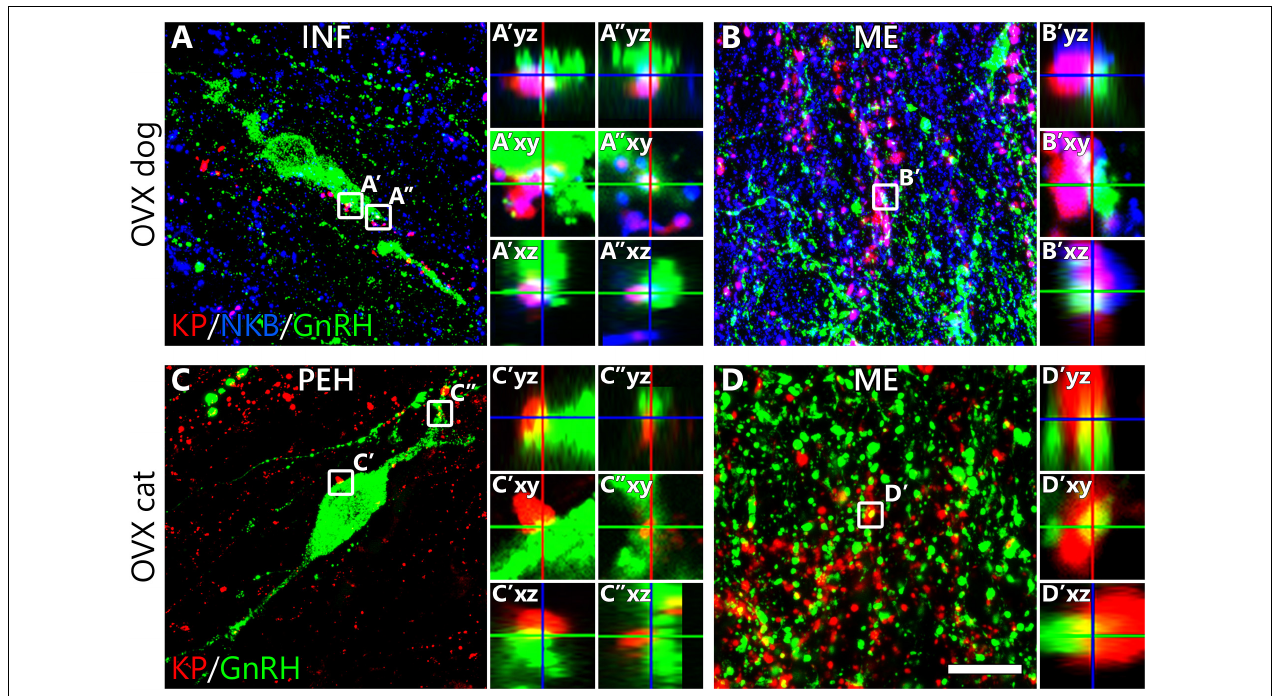
FIGURE 3 | Kisspeptin innervation of canine and feline gonadotropin-releasing hormone neurons. Results of triple- and dual-immunofluorescent studies on ovariectomized dogs (A,B) and cats (C,D) , respectively, reveal that kisspeptin (KP) fibers (red) establish axo-somatic (A’,C’) , axo-dendritic (A”,C”) and axo-axonal (B’,D’) contacts with gonadotropin-releasing hormone (GnRH)-immunoreactive (green) neurons. Successful detection of neurokinin B (NKB) in fibers of the canine hypothalamus allows the identification of KP fibers that arise from KP/NKB dual-phenotype neurons of the infundibular nucleus. High-power images of framed regions show absence of gaps between the juxtaposed profiles in orthogonal side-views of contacts. INF, infundibular nucleus; ME, median eminence; PEH, periventricular complex of the hypothalamus; Scale bar: 20 µ m in panels (A,C) (4 µ m in insets), 16 µ m in panels (B,D) (3 µ m in